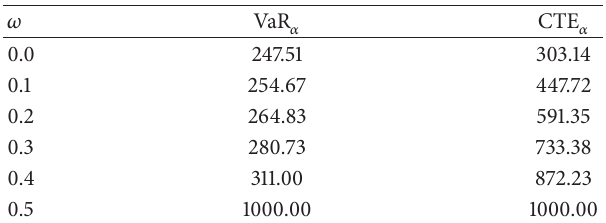
Figure 3: The approximated CTEs of 𝑆 1000 , by confidence level 𝛼 and the limiting correlation 𝜔 , under the 𝛽 -ICM model. Table 1: The approximated VaR and CTE of 𝑆 1000 at confidence level 𝛼 = 0.95 , under the 𝛽 -ICM